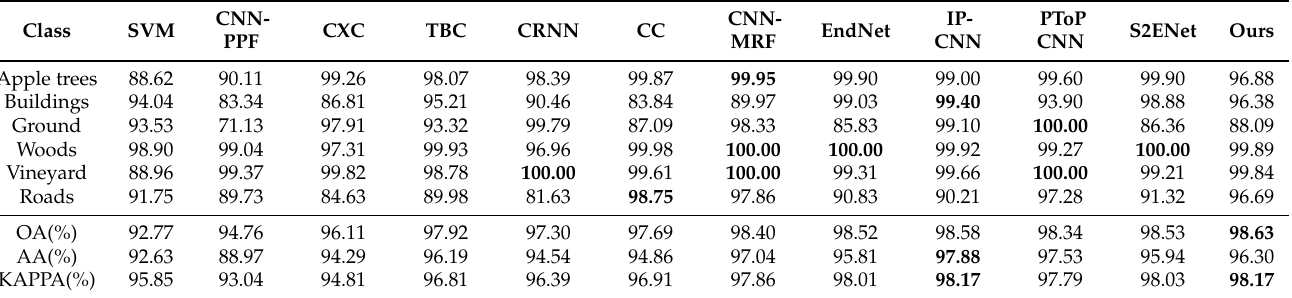
Table 2. Comparative experiment of the Trento dataset.